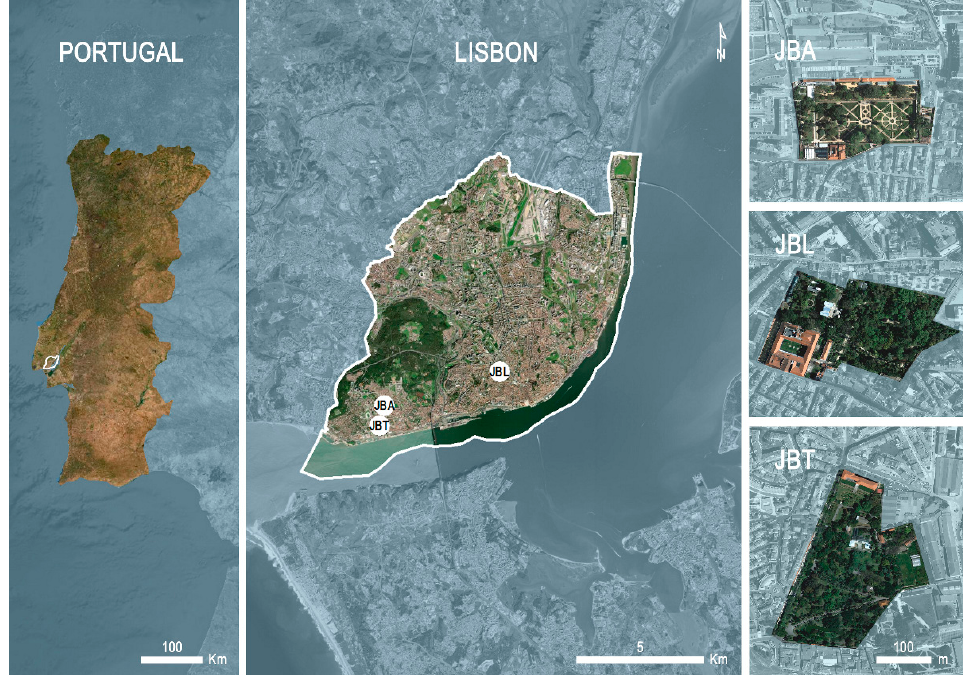
Figure 1. Location of the three Botanical Gardens in Lisbon. Right-top: Botanical Garden of Ajuda (JBA); right-center: Lisbon Botanical Garden (JBL); and right-bottom: Tropical Botanical Garden